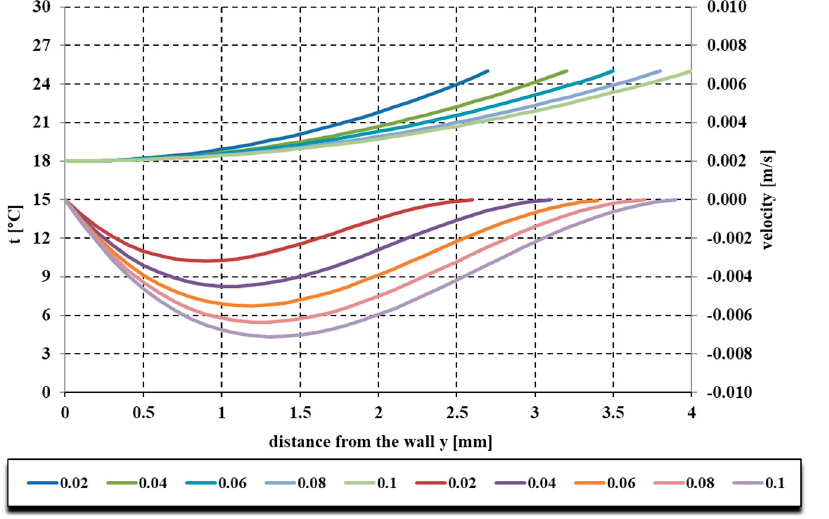
Figure 9. Dependence of rib height on velocity and temperature profile of the boundary layer. (wall temperature t w = 18 °C).